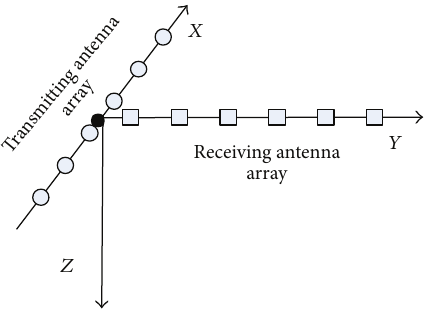
Figure 1: Distribution of T-shaped MIMO radar antenna